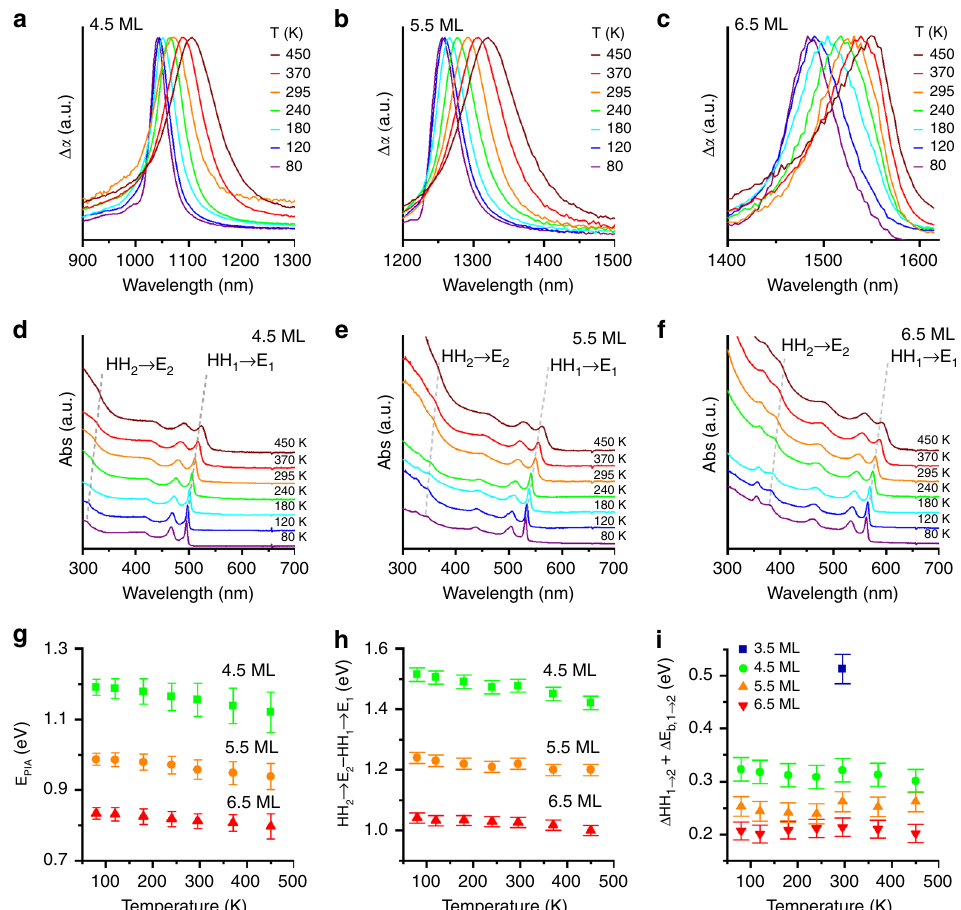
Fig. 4 Temperature dependence of intersubband absorptions. NIR-photoinduced absorption of a 4.5 ML, b 5.5 ML, and c 6.5 ML CdSe CQWs. Transient absorption spectra are for 10 ps delay after 420 nm excitation at indicated temperatures. Static absorption spectra of d 4.5 ML, e 5.5 ML, and f 6.5 ML CdSe CQWs. g Fitted energies of the NIR-photoinduced absorption feature plotted vs. temperature. The bars represent the full-width at half-maximum of the feature. h E HH 2 ! E 2 ½ (cid:2) (cid:3) E HH 1 ! E 1 ½ (cid:2) from static absorption spectra of CdSe CQWs, plotted as a function of temperature. Error bars represent the summed error of the two band positions, based on the bandwidth of the measurement. i Energy gap of the observed intersubband absorptions in ( g ) with E HH ! E ½ (cid:2) (cid:3) E HH ! E ½ (cid:2) from ( h ). This gap is equivalent to the heavy-hole intersubband absorption energy and differences in the exciton binding 2 2 1 1 energy of the n = 1 and n = 2 interband absorptions, which is printed on the plot. For reference, the 3.5 ML CQW data from room temperature is also included. Error is estimated as in ( h